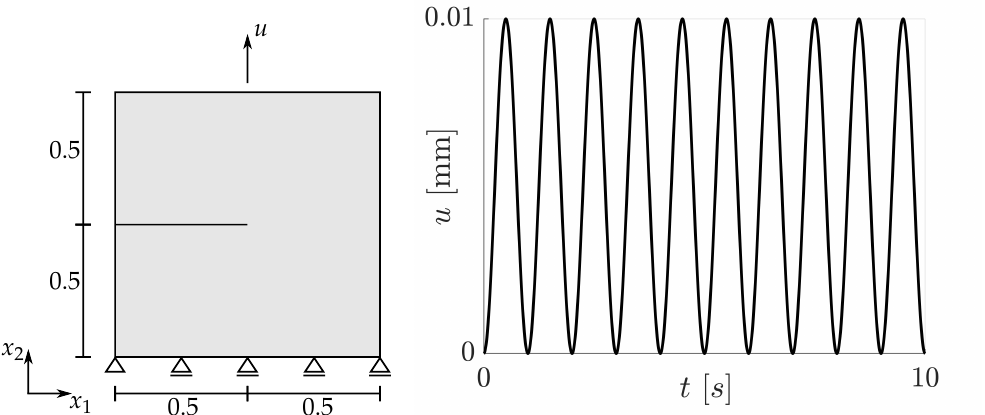
Figure 2. Geometry and loading history for the cracked specimen. The specimen is discretized by 6684 linear, four-node plane strain elements. All dimensions are in mm.